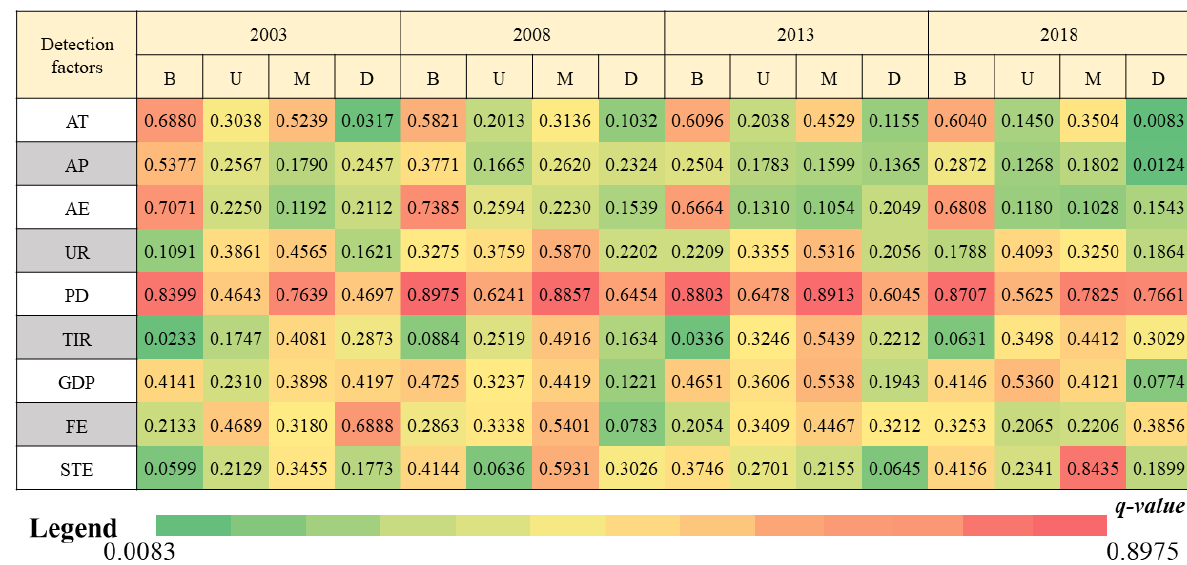
Figure 7. Detection results of the coupling coordination factor in the YRB. B, basin; U, upstream; M, midstream; D, downstream; AT, average annual temperature; AP, average annual precipitation; AE, average elevation; UP, urbanization rate; PD, population density; TIR, tertiary industry ratio; GDP, gross domestic product; FE, finance expenditure; STE, science and technology expenditure. Table 5. Changes and influence degrees of CCD factors in the